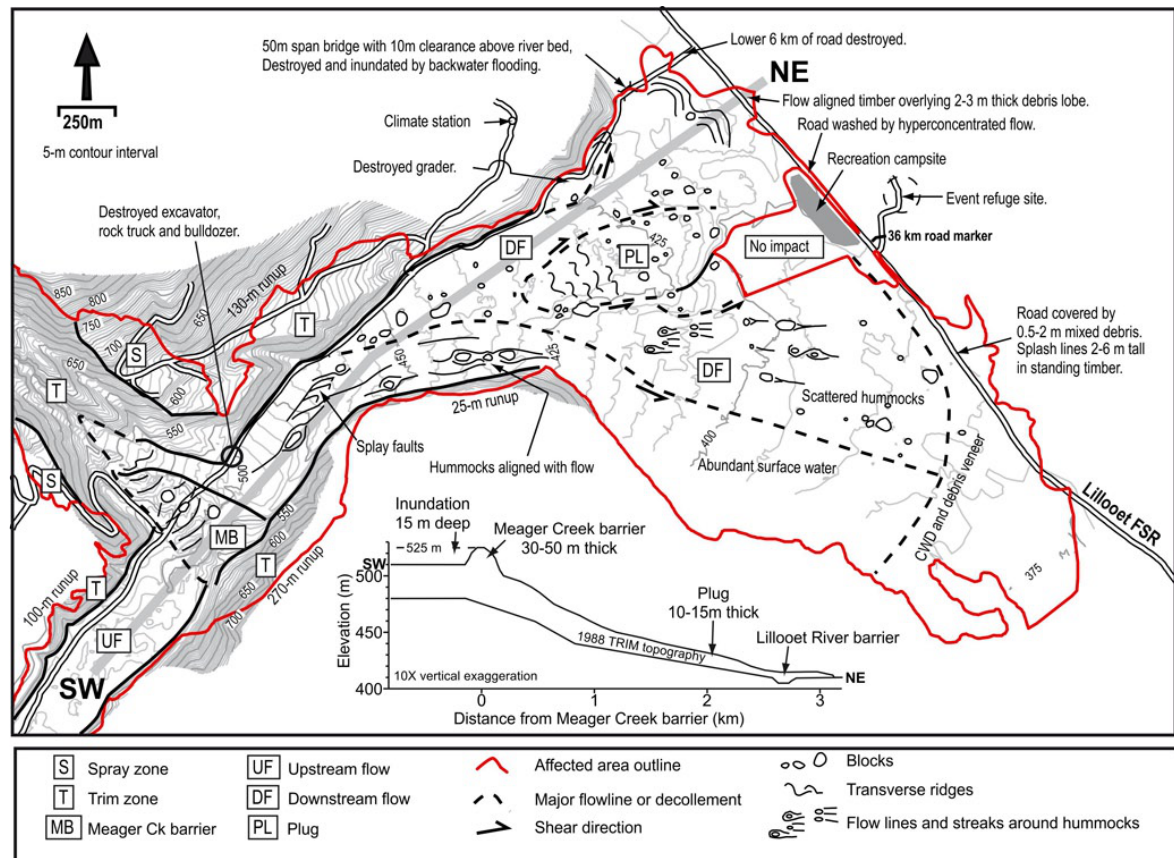
Fig. 14. Map of the landslide deposit in the valleys of lowermost Meager Creek and Lillooet River (see text for description).